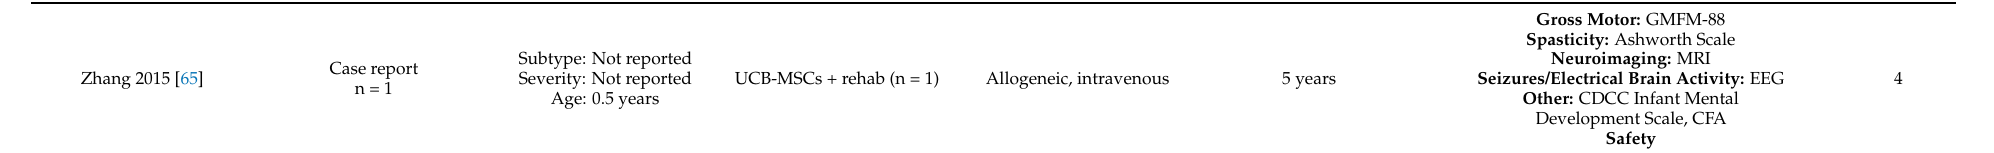
BRIEF, Behavior Rating Inventory of Executive Function; BSID-2, Bayley Scales of Infant and Toddler Development 2nd edition; BSID-3, Bayley Scales of Infant and Toddler Development 3rd edition cognitive scale; CDCC, Child Development Center of China; CFA, Comprehensive Functional Assessment; CFCS, Communication Function Classification System; CHQ,